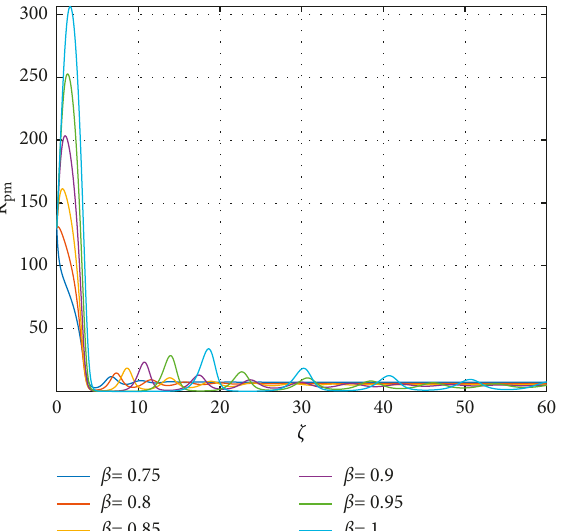
Figure 11: Two-dimensional illustration of the R orders β ∈ [ 0 , 1 ]